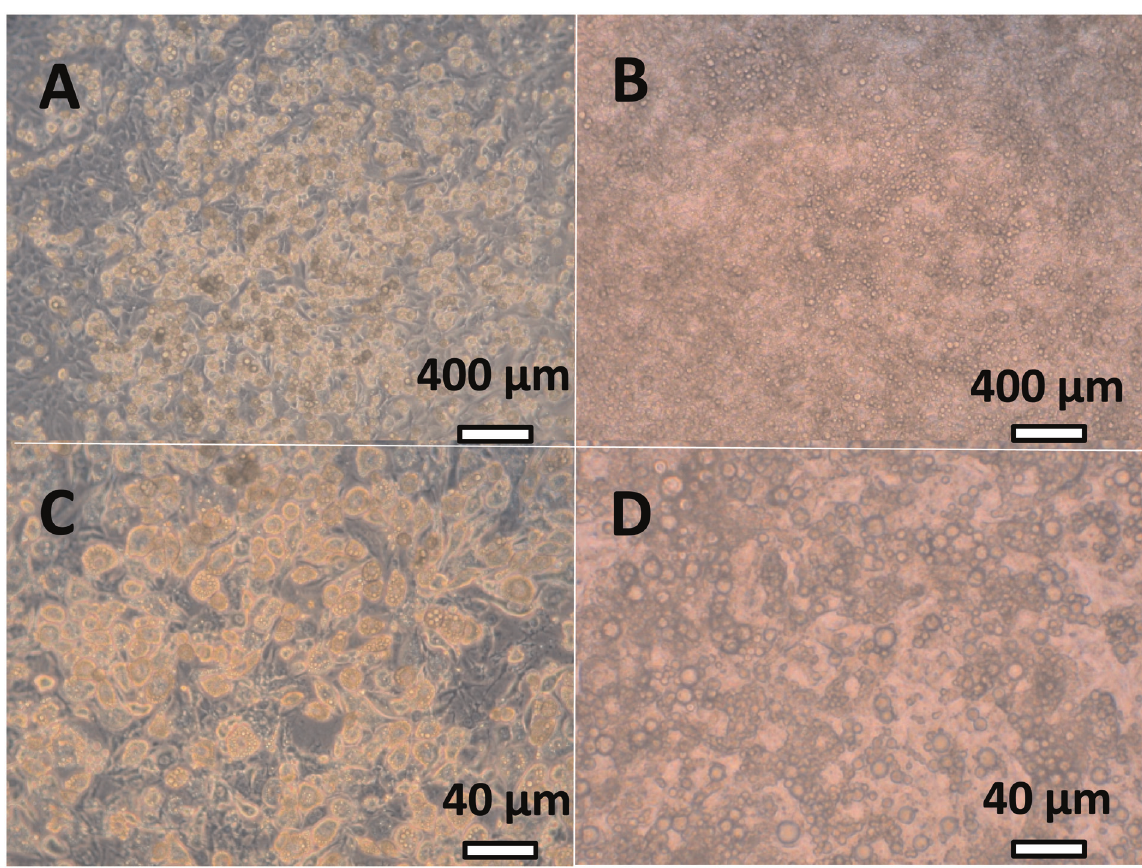
Fig 1. Microphotographs of 3T3-L1 cells in culture. The cells shown were maintained under the conditions described in the text. They are representative of the conditions used throughout the whole study. Photographs A and B are shown at a lower magnifying power than C and D. A white bar shows a reference for size. Panes A and C correspond to an ordinary 3T3-L1 culture, in which differentiated adipocytes and undifferentiated fibroblasts coexist. Panels B and D represent 3T3-L1 cultures incubates using Transwells, as described for this study. All wells used in this investigation were maintained under these same conditions; there was a total absence of undifferentiated fibroblasts, as previously described